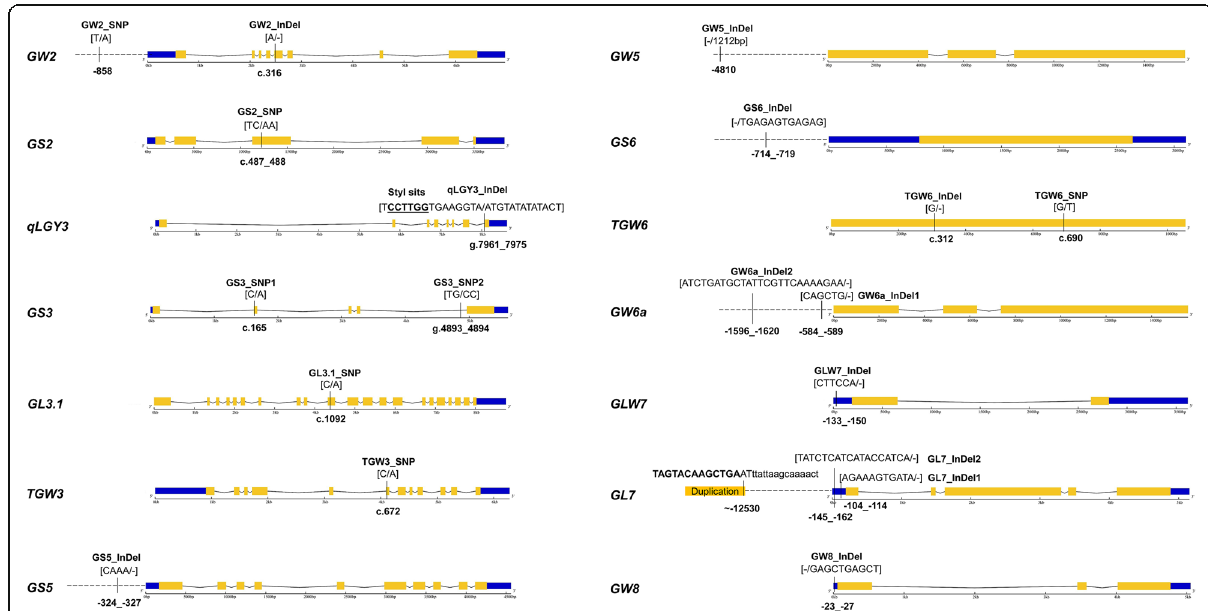
Fig. 1 Allele type and position of candidate FNPs of 14 grain size genes. The promoters, UTRs, exons and introns of different genes are expressed as dashed lines, blue boxes, orange boxes and fold lines respectively. The position of each variation is labeled the relative distance to the ATG in promoter ( − ), CDS (c) and genomic DNA (g). Allele variation of each gene is shown in square bracket, with the front nucleotide variation representing allele 1 from Nipponbare and the back nucleotide variation representing allele 2 from non-NIP-type